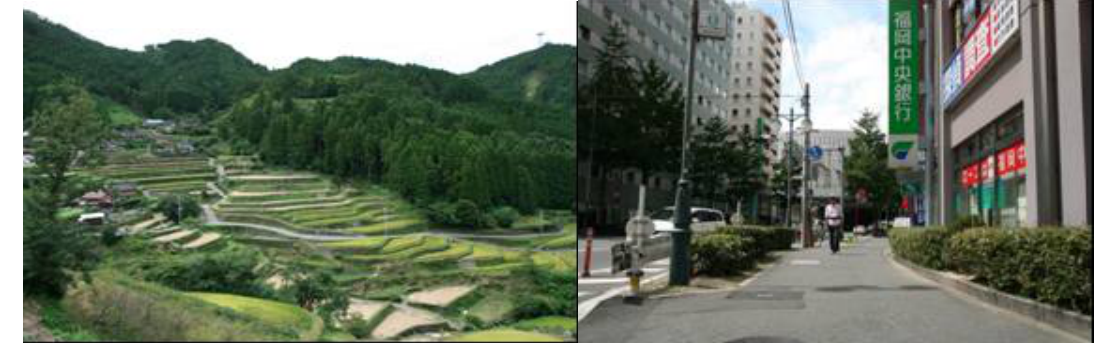
Figure 1. Rural landscape with terraced paddy field in Ukiha City ( Left ) and urban landscape with traffic and buildings in Fukuoka City ( Right ) in southwestern